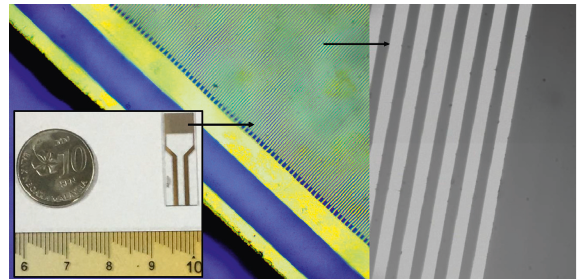
Figure 2: Surface of an interdigitated electrode sensor observed under both a high-power microscope (blue) and a 3D-nanoprofiler (grey). The figure inset shows the original sensing